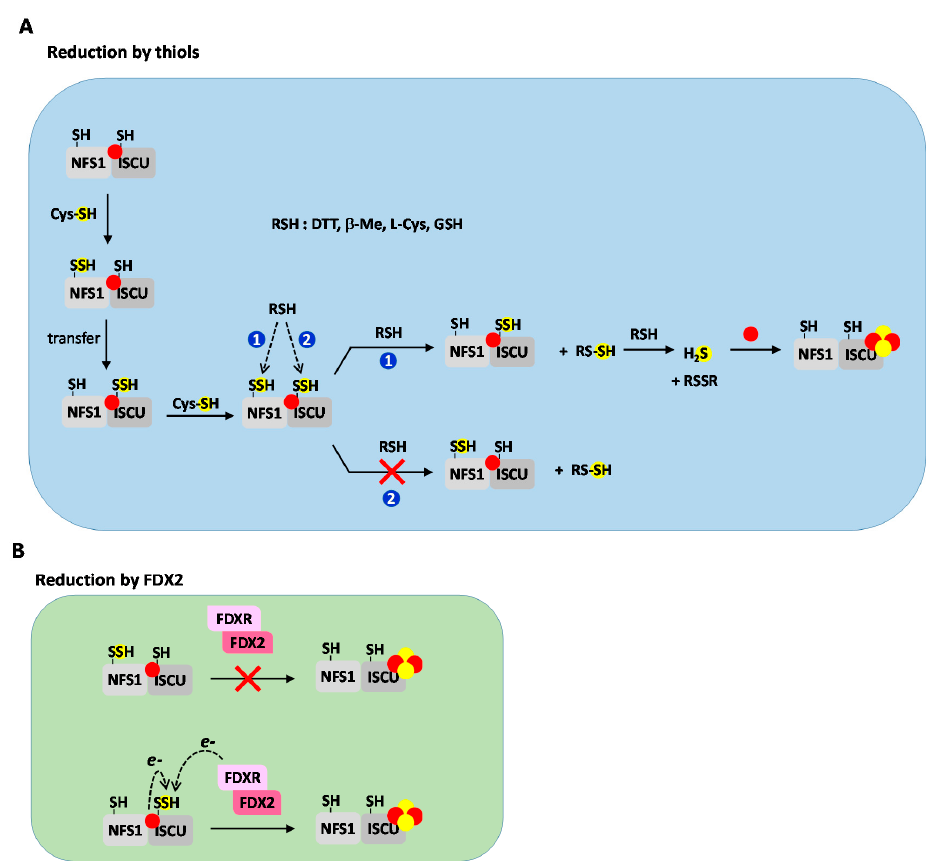
Figure 6. Selective reduction of the persulfide of NFS1 and ISCU by thiols and FDX2. ( A ) Thiols (RSH) such as dithiothreitol (DTT), L -cysteine, β -mercaptoethanol and GSH react with the persulfide of NFS1. Once a persulfide is formed it is transferred to ISCU, then a second persulfide is formed on NFS1. Thiols reduce the persulfide of NFS1 ( reaction 1 ), which generates free persulfidated thiol (RSSH) that reacts with a second molecule of thiol to liberate sulfide ions in solution. Sulfide exists as H 2 S, HS − and S 2 − depending on the pH, with HS − the predominant form at physiological pH (pH ≈ 8 in mitochondria). The sulfide ions react with iron to generate [2Fe2S] and [4Fe4S] clusters in ISCU. In contrast, the persulfide of ISCU is poorly reactive with thiols ( reaction 2 , the red cross indicates that the reaction does not occur), most likely due to the presence of the metal ion that shields Cys104. Thereby, sulfide ions originate mainly from reduction of NFS1. The dashed black arrows describe the reaction of the thiols on the persulfide of either NFS1 or ISCU ( B ) FDX2 does not reduce the persulfide of NFS1 (top, the red cross indicates that the reaction does not occur), but selectively reduces the persulfide of ISCU when iron is present in the assembly site (bottom). A mechanism is proposed in which FDX2 provides one electron and the ferrous iron of ISCU the second one to reduce the S–S bond of the persulfide. The dashed black arrows show the origins of these two electrons.